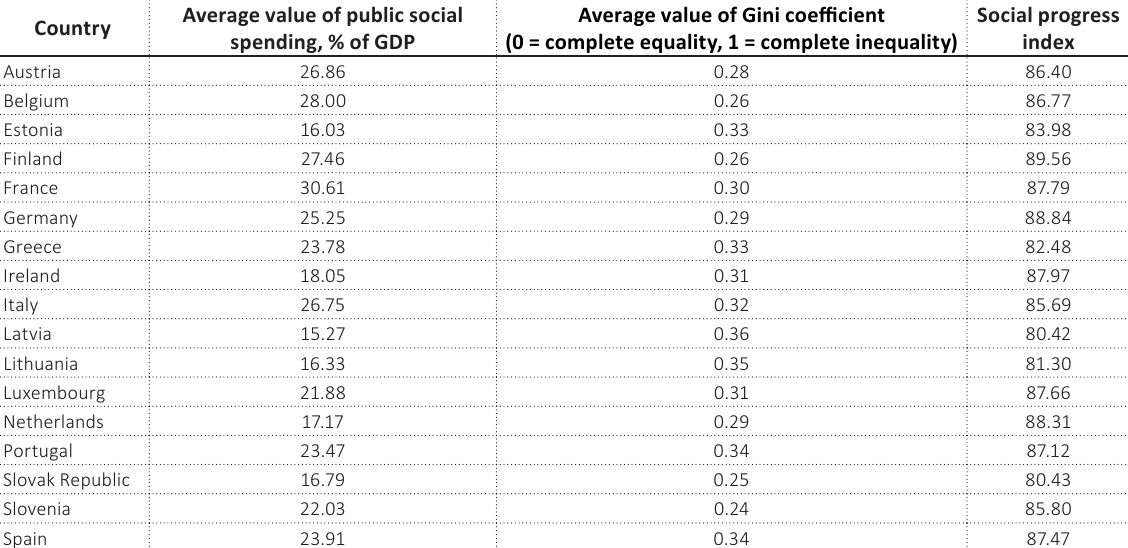
Table 1. Average values of the scope of social spending for 2005–2019 and the Gini coefficient and social progress index for 2019